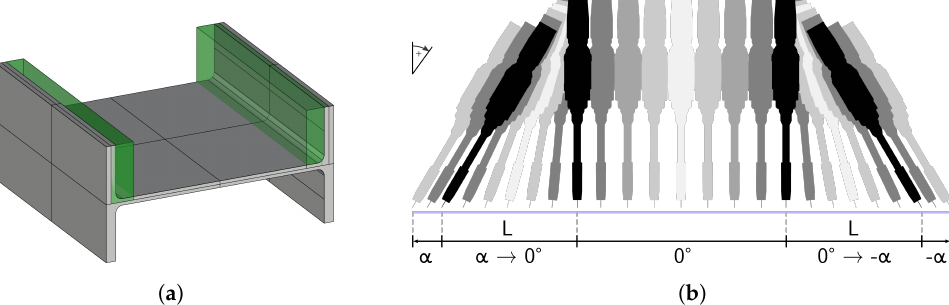
Figure 12. ( a ) Profile in Rhino with defined flange areas; ( b ) Movement of torch